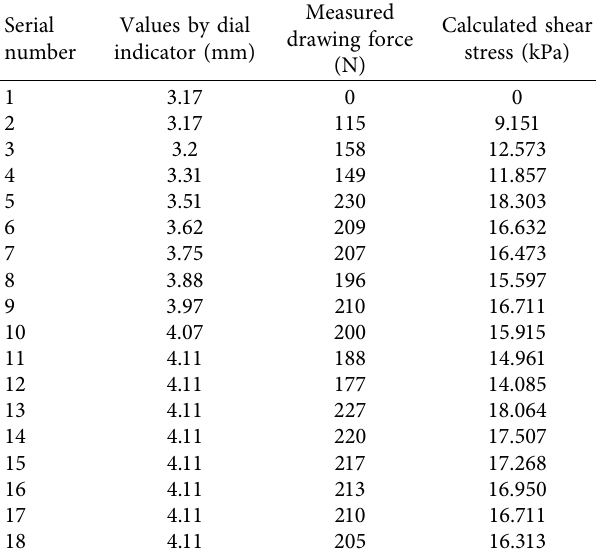
Table 2: The measured test values and calculated value of shear stress (the second test).